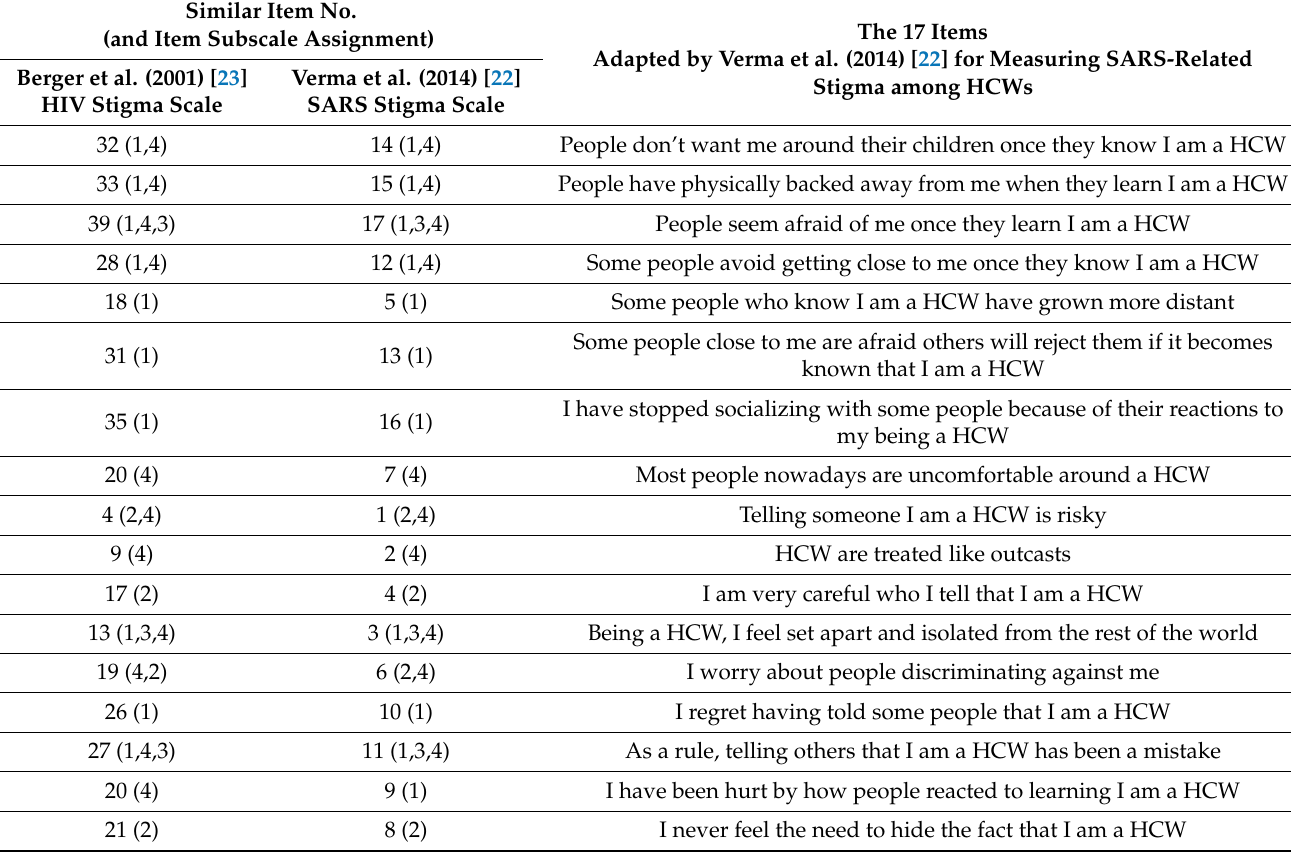
Table 1. Items included in Verma et al.’s SARS stigma scale, their subscale assignments, and the corresponding item numbers from Berger et al.’s HIV stigma